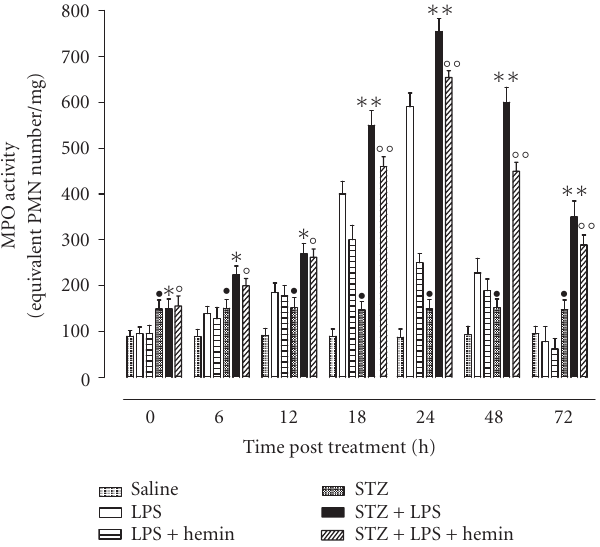
Figure 1: STZ-diabetes and HO-1 levels following EIU. Rats were treated ip with vehicle saline; LPS alone (nondiabetic); LPS+STZ (diabetic), or hemin (50mg/kg 1h prior to LPS or LPS+STZ). Sig- nificance is expressed as • P < . 05 versus vehicle saline nondiabetic rats; ∗ P < . 05 and ∗∗ P < . 01 versus LPS nondiabetic rats; ◦ P < . 05 and ◦◦ P < . 01 versus LPS+hemin nondiabetic rats.